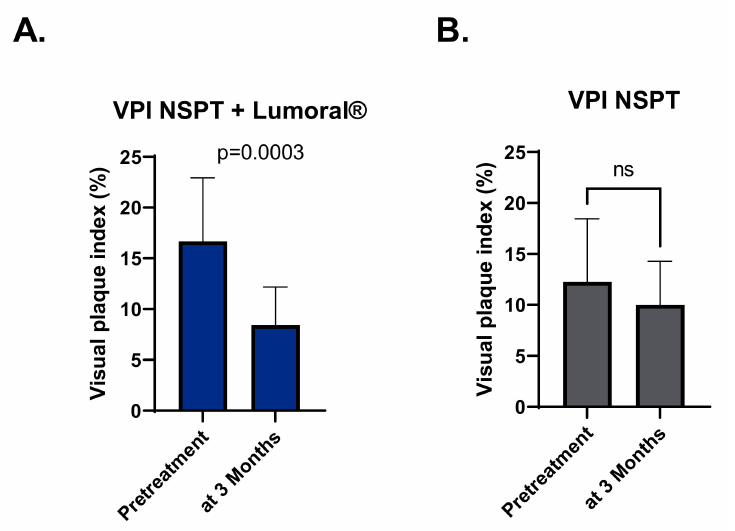
Figure 4. ( A ) VPI (%) in the NSPT + Lumoral ® group at the beginning of the study and three months. ( B ) VPI (%) in the NSPT group at the beginning of the study and three months. VPI = visual plaque index, NSPT = non-surgical periodontal